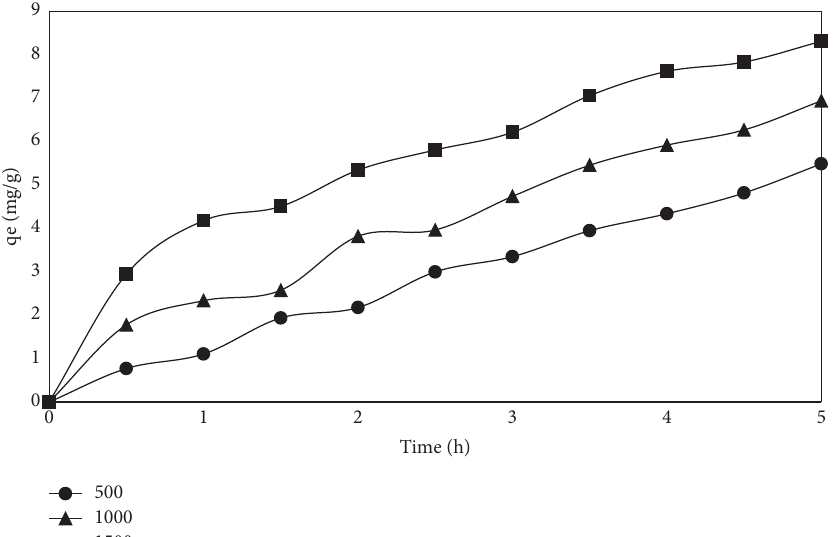
Figure 7: Efect of stirring velocity on the adsorption of MB molecules on PVB/bentonite nanofbers at 27 ° C and pH 9. Initial dye concentration of 20mg/L.